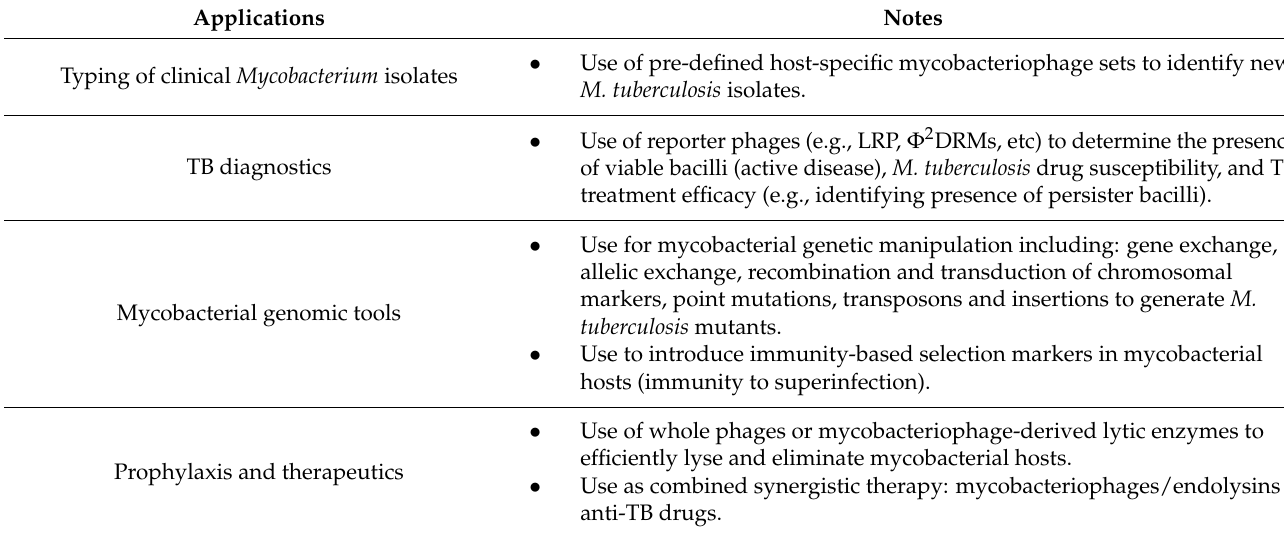
Table 1. Applications of mycobacteriophages in